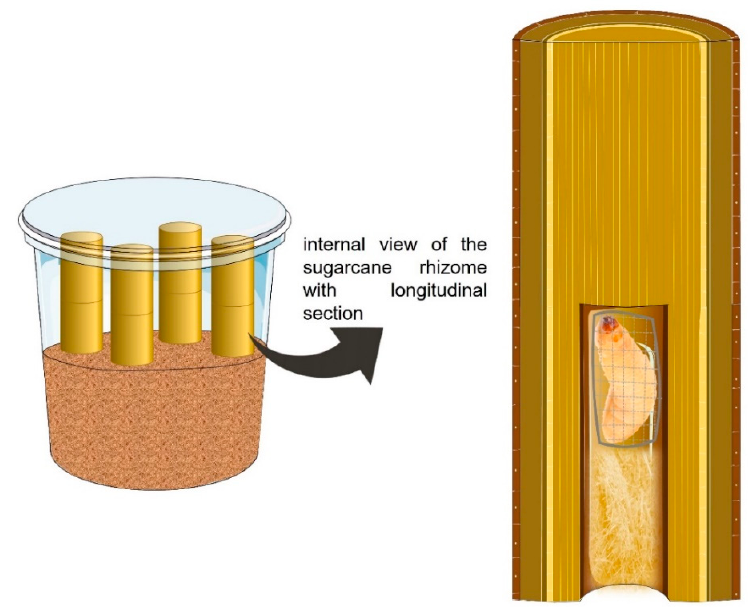
Figure 1. Galleria mellonella larvae held inside a metal cage and inserted inside a cane rhizome partially buried in the